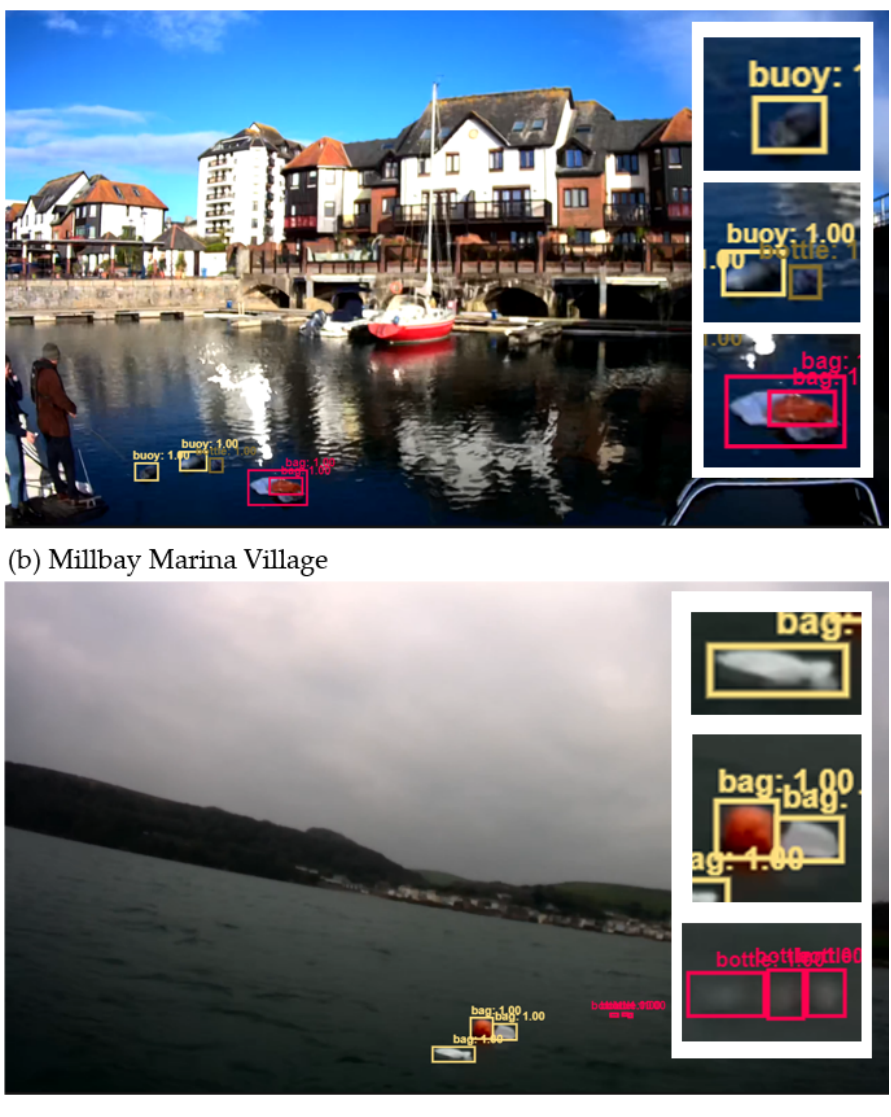
Figure 5. Training images containing plastic items used for training from ( a ) Turnchapel Wharf, ( b ) Millbay Marina Village and ( c ) Cawsand Bay. The image from Turnchapel Wharf is taken on the MAS and contains three transparent bottles. The image at Millbay Marina Village is taken on the Explorer. Two buoys and two bags can be seen in this image. The image taken from Cawsand Bay is taken on the MAS. This image contains three bags, two white and one orange. The image also contains three transparent